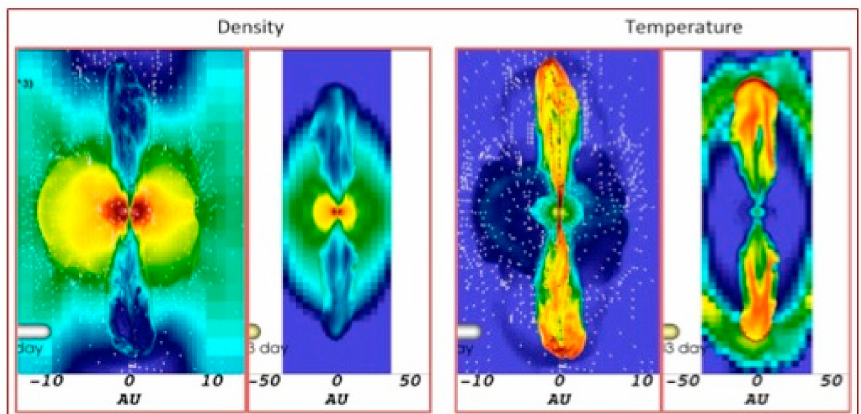
Figure 1. 2-D slices in the X-Z plane of log density ( right ) and log temperature ( left ) from 3-D AMR simulations of a high momentum fast wind being driven into CEE ejecta. We showed two different times for the simulations. Each left sub-panel is at t = 780 days after initiation of fast wind. Each right sub-panel is at t = 1600 days after initiation of fast wind. Note the change of scale between the two times as the nebular lobes